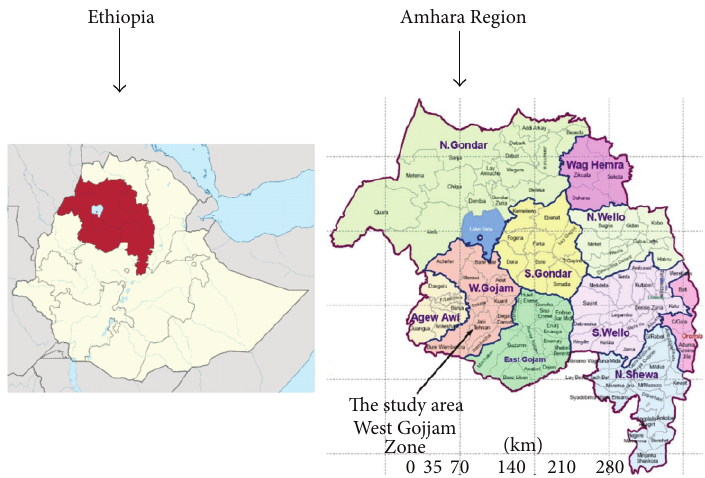
Figure 1: Map of Ethiopia, Amhara Region, and the study